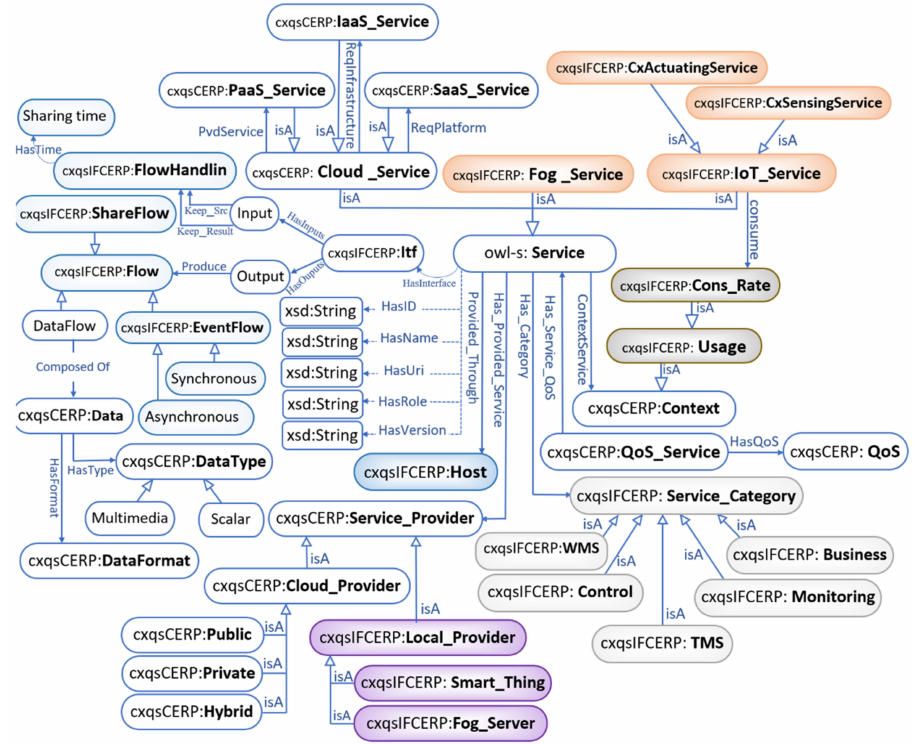
Figure 6. A semantic model of context-aware intelligent